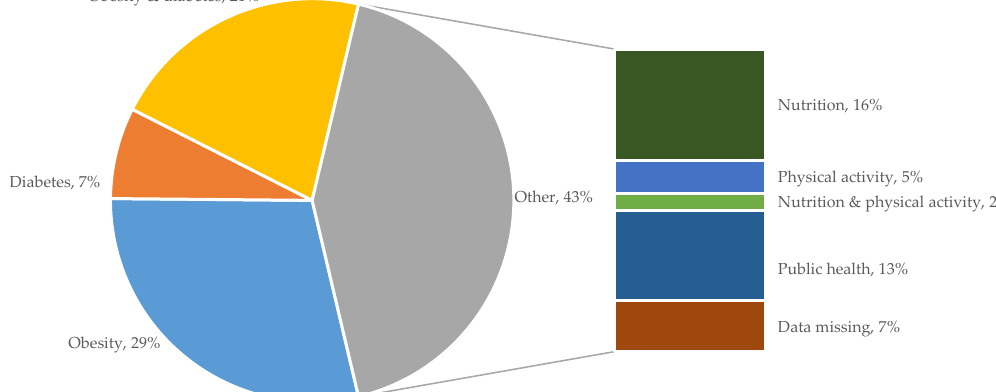
Figure 5. Nominated expertise of individuals in the network. The main pie shows the fraction of key actors who were regarded as obesity and/or diabetes specialists. The grey section groups all individuals with an area of expertise that relates to diabetes and obesity, including nutrition, physical activity, and public health.